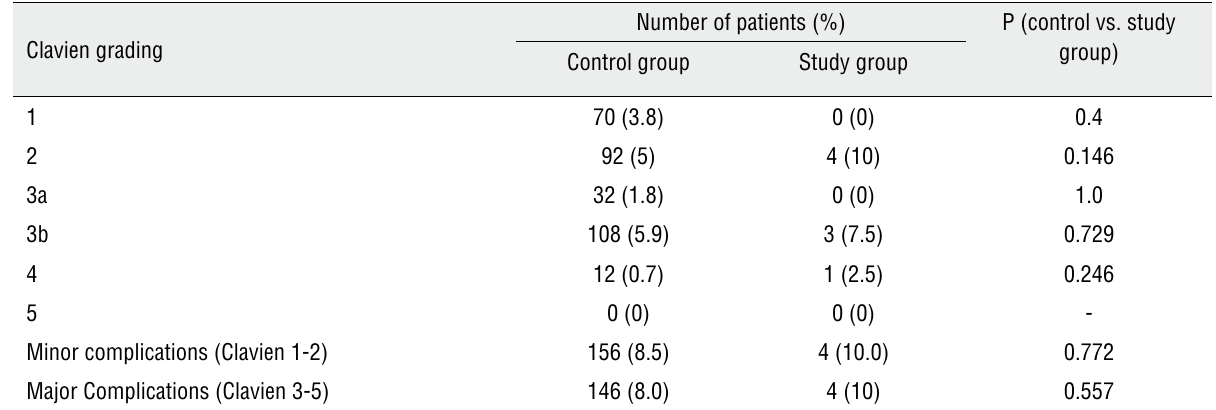
Number of patients (%) P (control vs.